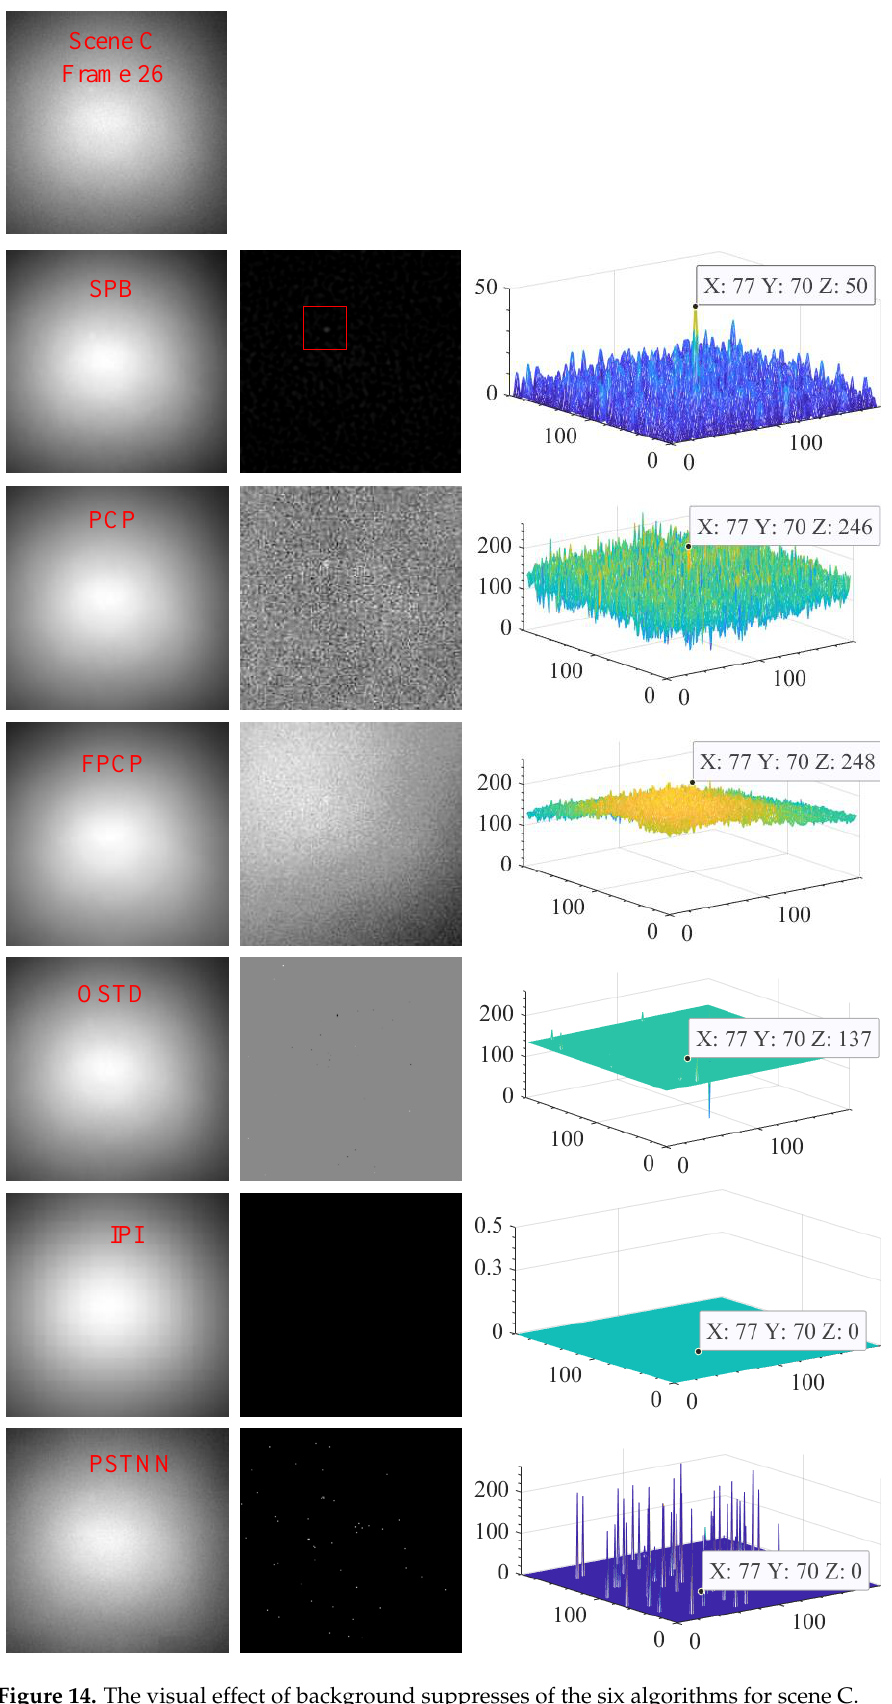
Figure 14. The visual effect of background suppresses of the six algorithms for scene C.